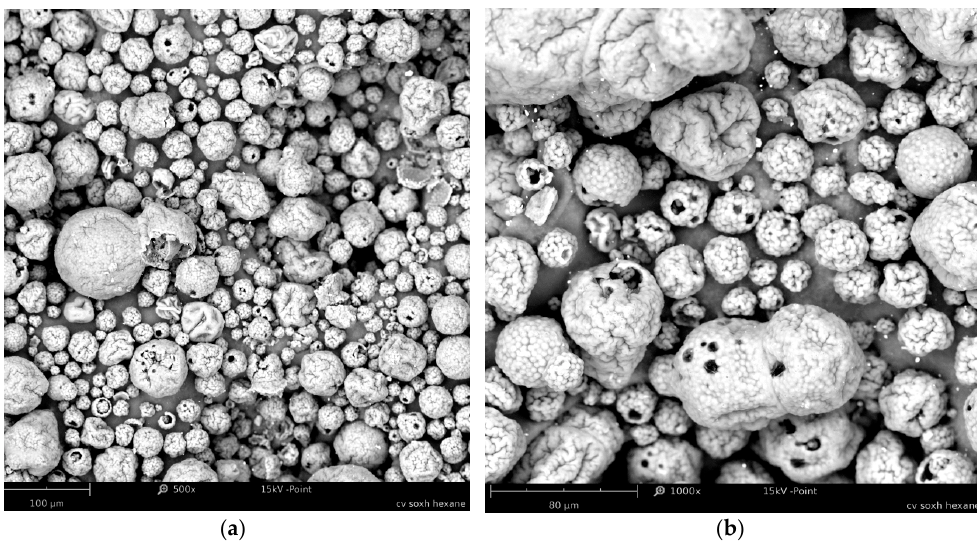
Figure A2. SEM image of dried Chlorella SP. after Soxhlet extraction by hexane at ( a ) 500× magnification, 15 kV; ( b ) 1000× magnification, 15 kV.